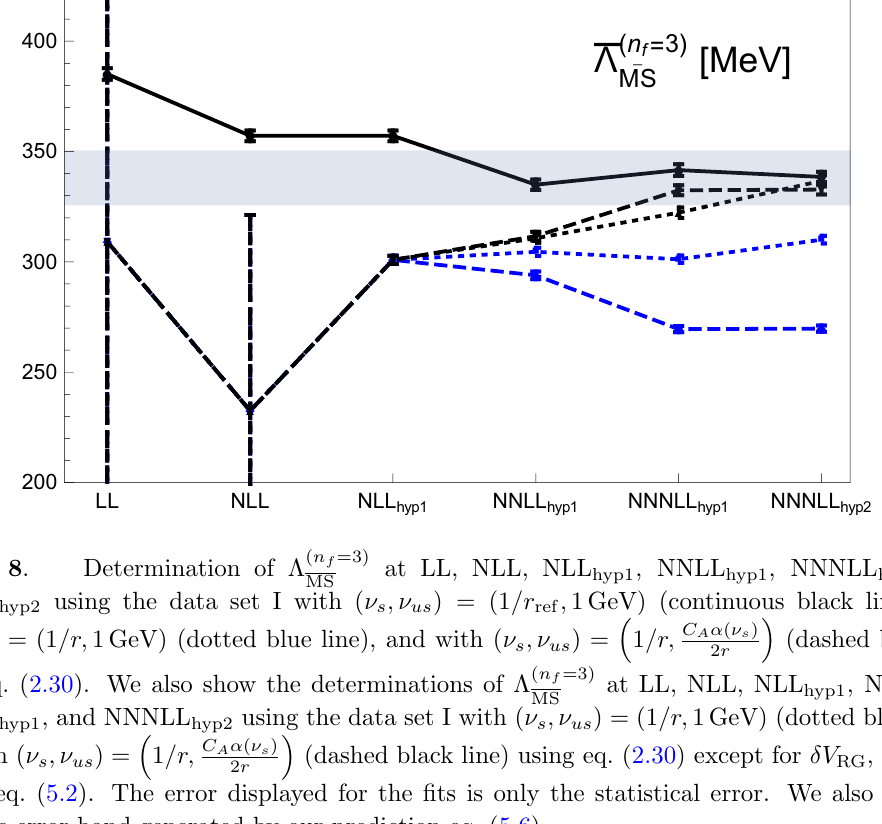
Figure 8 . Determination of (cid:3) ( n f =3) at LL, NLL, NLL hyp1 , NNLL hyp1 , NNNLL hyp1 , and MS NNNLL hyp2 using the data set I with ( (cid:23) s ; (cid:23) us ) = (1 =r ref ; 1 GeV) (continuous black line), with (cid:16) (cid:17) ( (cid:23) s ; (cid:23) us ) = (1 =r; 1 GeV) (dotted blue line), and with ( (cid:23) s ; (cid:23) us ) = 1 =r; C A (cid:11) ( (cid:23) s ) (dashed blue line) 2 r using eq. (2.30). We also show the determinations of (cid:3) ( n f =3) at LL, NLL, NLL hyp1 , NNLL hyp1 , MS NNNLL hyp1 , and NNNLL hyp2 using the data set I with ( (cid:23) s ; (cid:23) us ) = (1 =r; 1 GeV) (dotted black line), (cid:16) (cid:17) and with ( (cid:23) s ; (cid:23) us ) = 1 =r; C A (cid:11) ( (cid:23) s ) (dashed black line) using eq. (2.30) except for (cid:14)V RG , for which 2 r we use eq. (5.2). The error displayed for the (cid:12)ts is only the statistical error. We also show